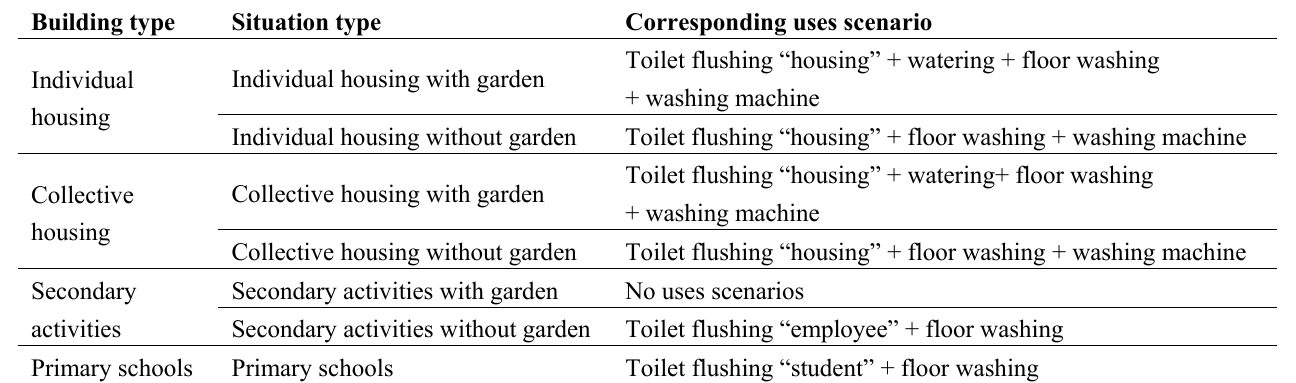
Table 6. Situation types and uses scenarios studied for Colombes.